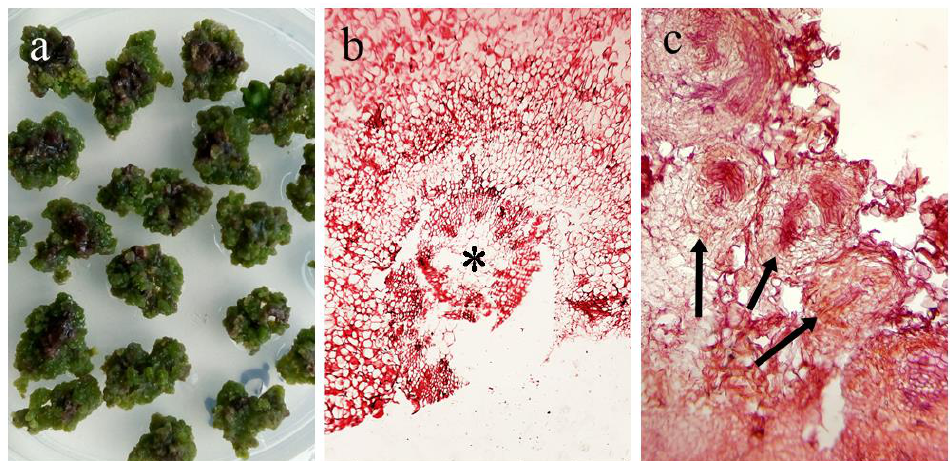
Figure 2. Histological analysis of L. rivularis callus induced under in vitro culture conditions. ( a ) Callus structures; ( b ) cells at the contact surface 21 days after callus induction, * shows an initial internodal section and following dedifferentiation; ( c ) arrows indicate meristemoids formation.